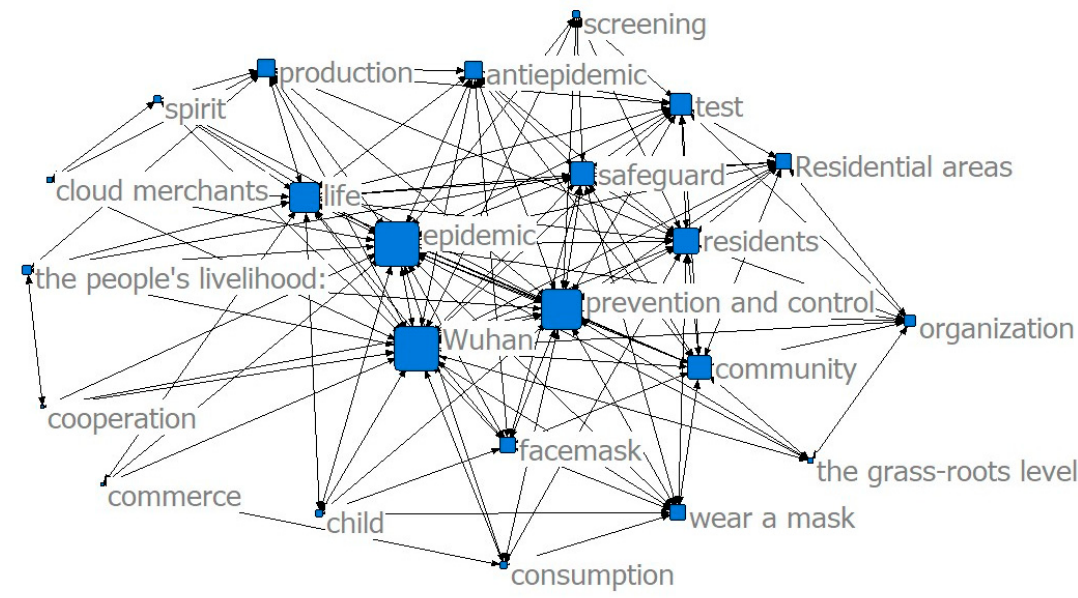
Figure 7. Community service demands in the normal period.